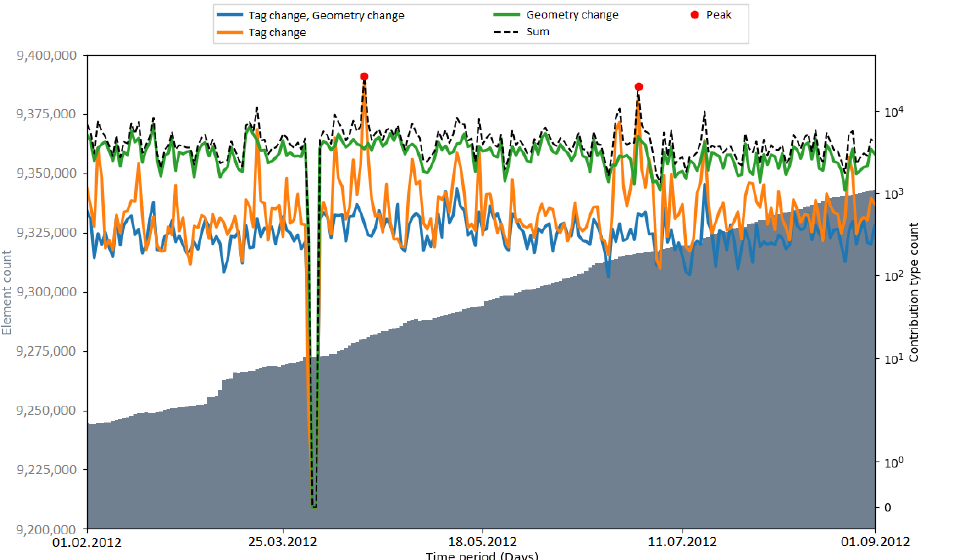
Figure A11. Contribution types during the observation period without a large data import in the